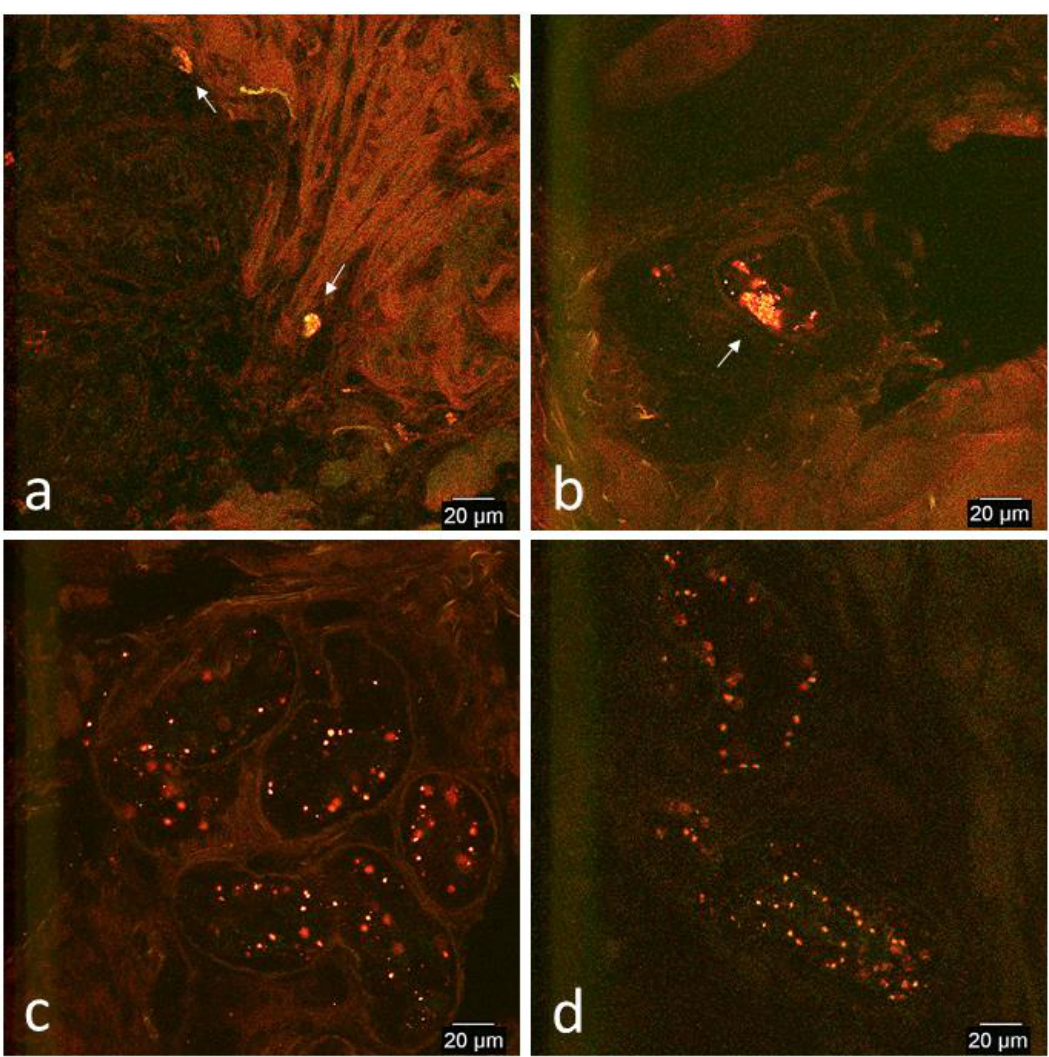
Figure 6. Representative confocal microscopy images of biopsies of limb and thoracic wounds and contralateral non-wounded skin on day 7. ( a ) Wounded limb, ( b ) non-wounded limb, ( c ) wounded thorax, and ( d ) non-wounded thorax. Images were selected from either horse based on best representation of patterns typical fluorescent signal patterns of both horses. Images have been selectively enhanced for purposes of demonstrating signal variation. Red and green signal was detected in all wounded and non-wounded biopsies. There was no di ff erence in homing to wounds in either horse except for an area of the wounded thorax in horse 2 that had several cell-like structures. Signal was located within the vasculature along the endothelium in both horses ( c , d ) and cell-like structures consistent with in vitro CBMSCs were occasionally detected adjacent to or within the vasculature of all biopsies (arrow, b ).